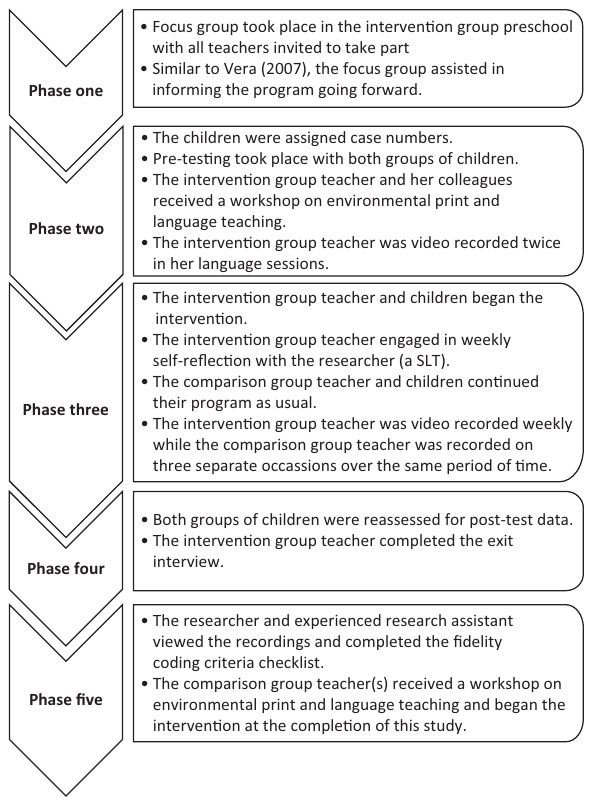
FIGURE 2: Data collection procedures.